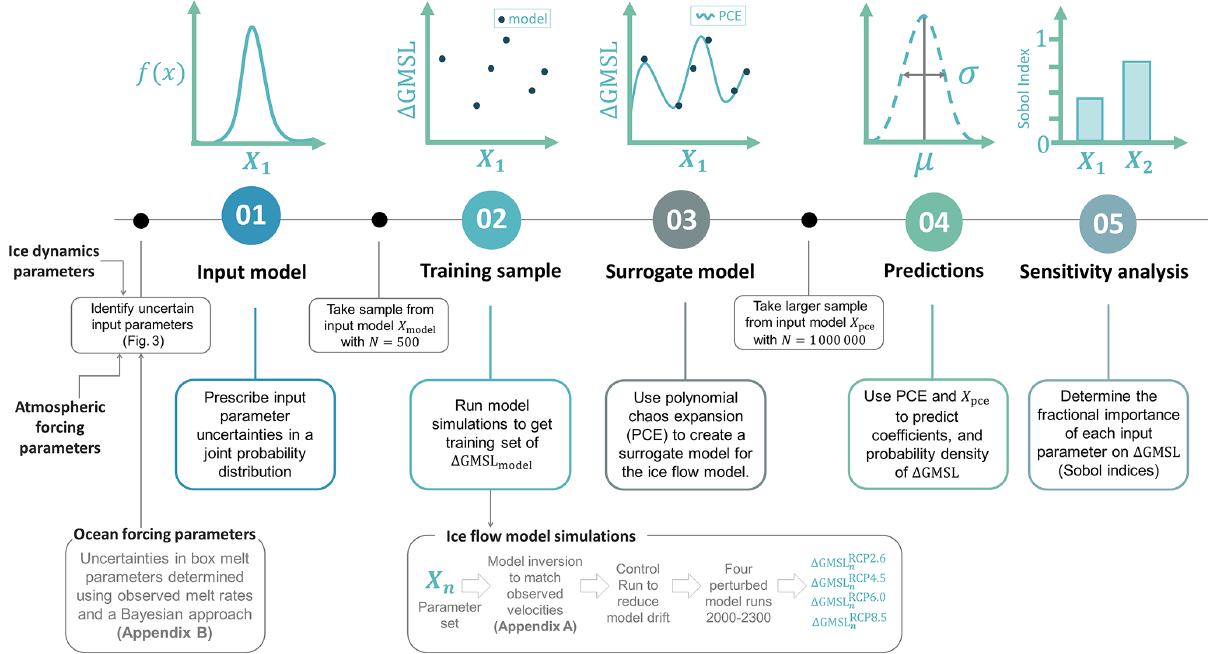
Figure 2. Workflow diagram summarizing the uncertainty quantification approach used in this study. We first identify uncertain input pa- rameters and represent them in probabilistic framework. A training sample of 500 points is taken from this input parameter space and used as input to an ensemble of simulations in our ice flow model, which we hereafter refer to as our “training ensemble”. Using this training sample and the surrogate modelling capabilities in UQLAB we create a polynomial chaos expansion (PCE) that mimics the behaviour of our ice flow model. This allows us to evaluate a much larger sample from our parameter space, and these surrogate models are used to derive predictions and probability density functions for changes in global mean sea level ( (cid:49) GMSL). Finally, we use sensitivity analysis to identify the proportional contribution of each input parameter on projection